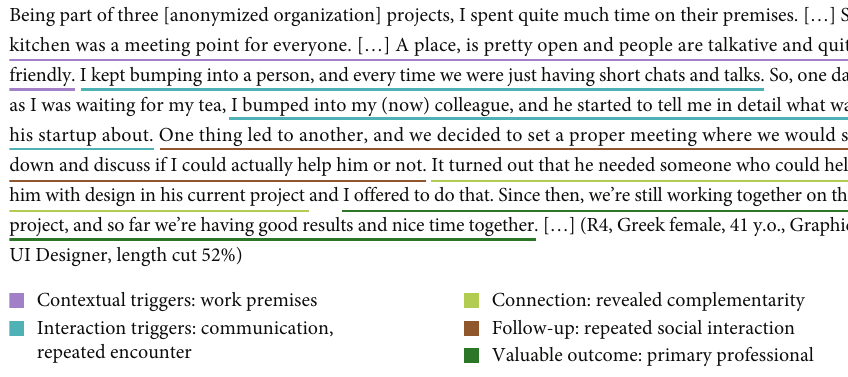
Figure 5: An excerpt from a respondent’s story about how the work environment facilitated a serendipitous social